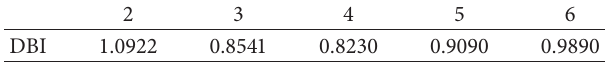
Table 4: Indicator results under different